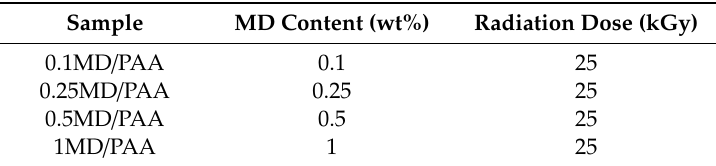
Table 2. Characteristics of metronidazole containing poly (acrylic acid) hydrogel films with di ff erent MD